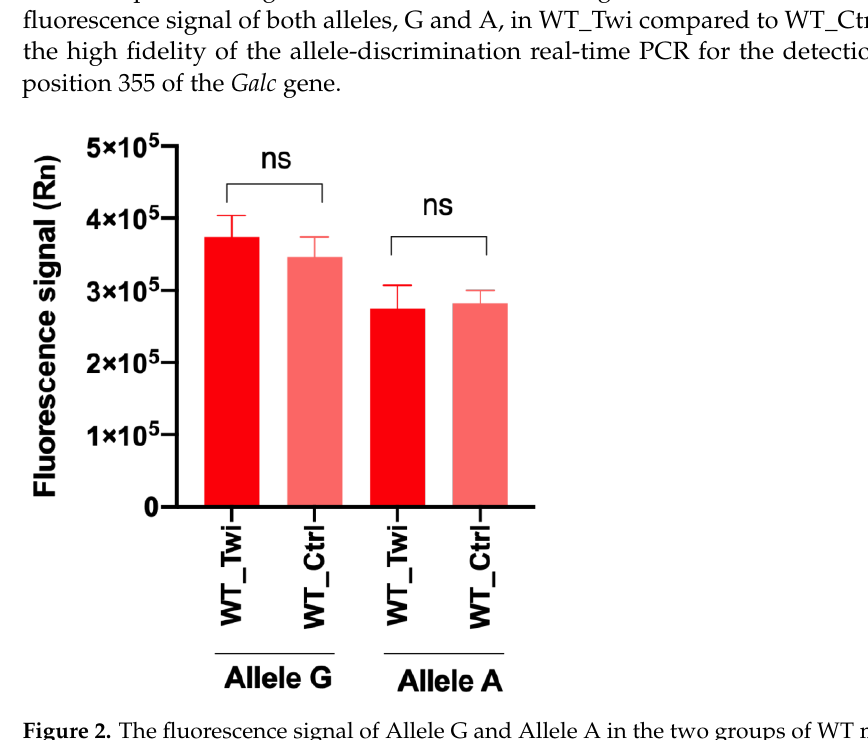
Figure 2. The fluorescence signal of Allele G and Allele A in the two groups of WT mice, WT_Twi compared to WT_Ctrl. Student’s t-test analysis, ns = not significant.